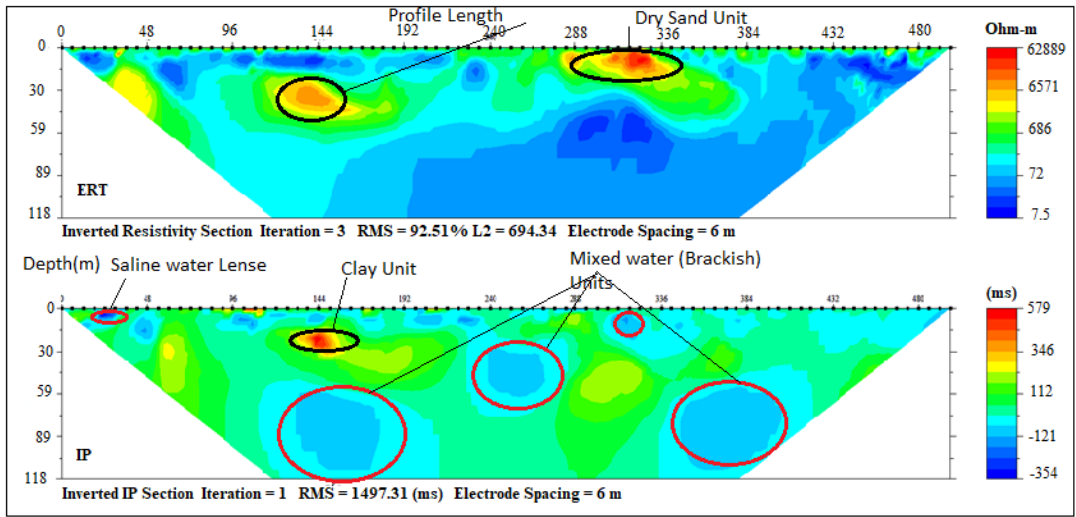
Figure 8. Inverted resistivity and IP cross-sections Ebute Ipare (Profile section P5).